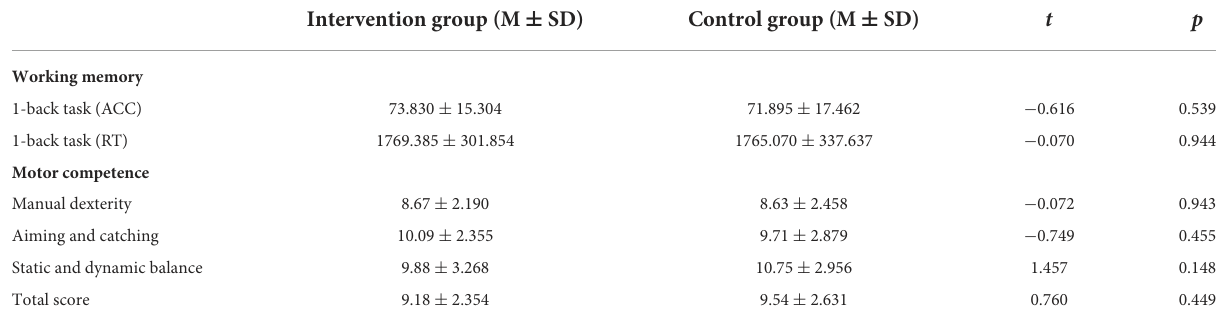
TABLE 3 Baseline characteristics of participants.